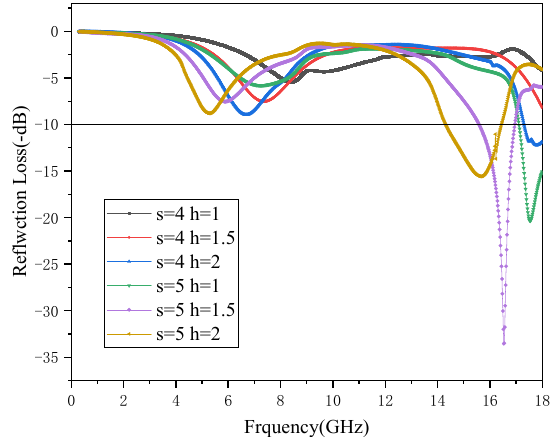
Figure 11. RL spectra of different honeycomb models.